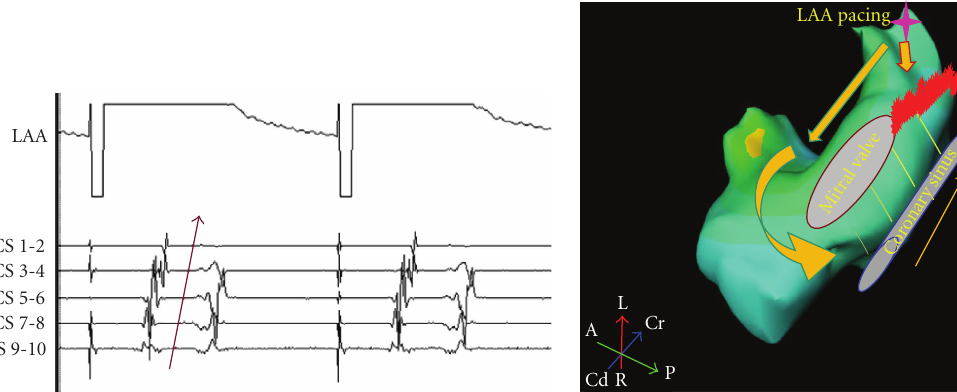
Figure 6: Left atrial appendage (LAA) pacing ( ) results in proximal to distal activation (arrow) of coronary sinus (CS). This is suggestive of blocked ( ) posterolateral mitral isthmus, at least, unidirectionally. CS 9-10—proximal CS, CS 1-2—distal CS.